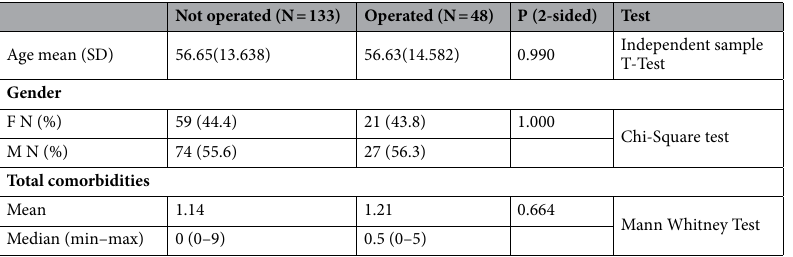
Table 2. Demographics and total comorbidities of both groups.